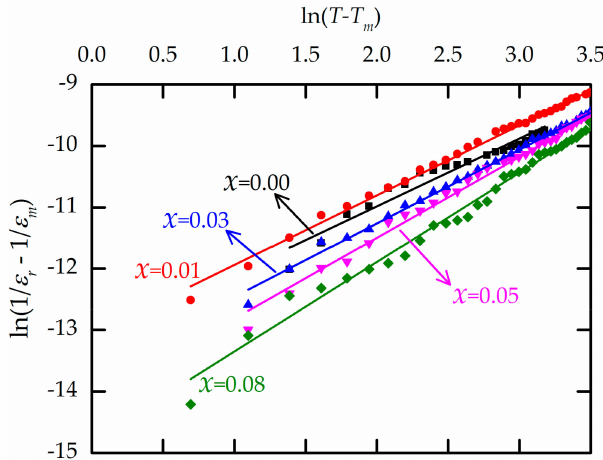
Figure 6. Linear relationships between ln(1 / ε r − 1 / ε m ) and ln( T − T m ) for all x